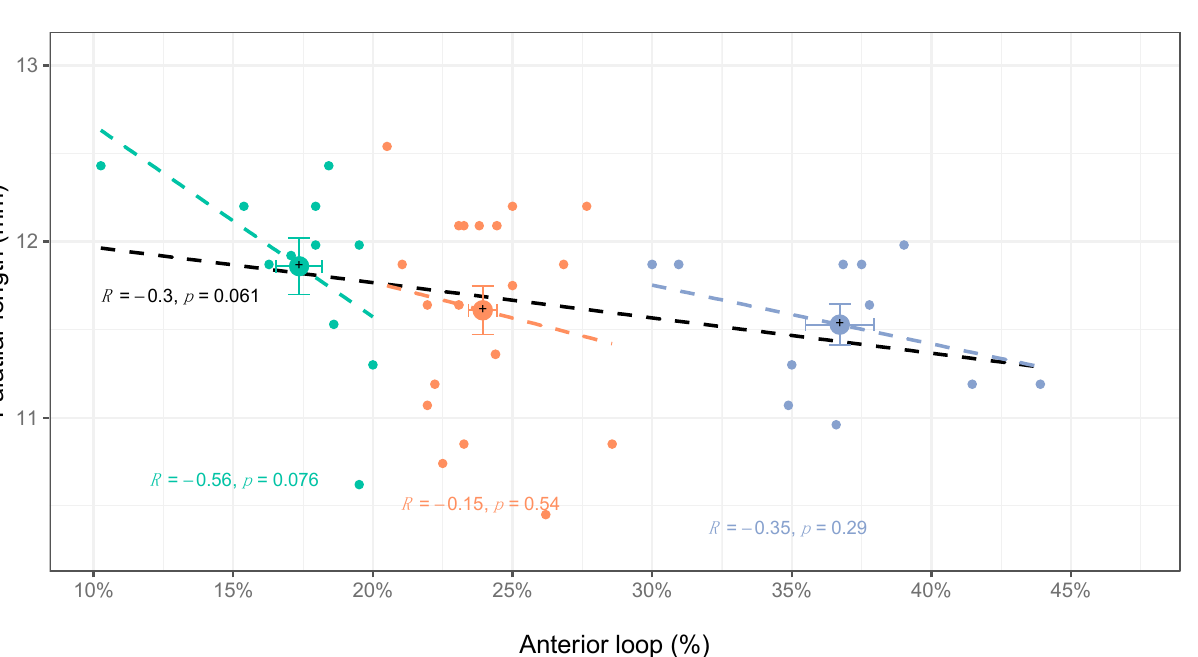
8 of 14 Figure 5. ( A ) Distribution of the row scores of the fi rst two components of PCA. The p value of Bonferroni tests reveals whether signi fi cant di ff erences are present between the geographical populations. Colours are consistent with those used in Figure 2. ( B ) Individual PC scores and odontometric variables. The ellipses contain 95% of the data. The examination of the morphospace obtained through a PCA analysis and testing